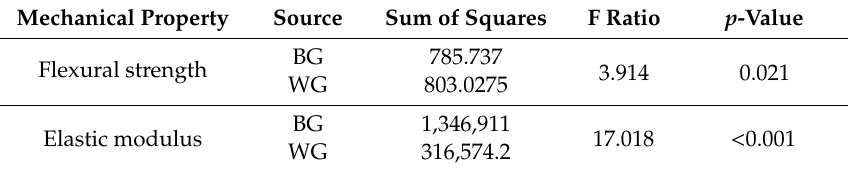
Table 7. ANOVA test for flexural strength and modulus obtained after ageing treatments. Mechanical Property